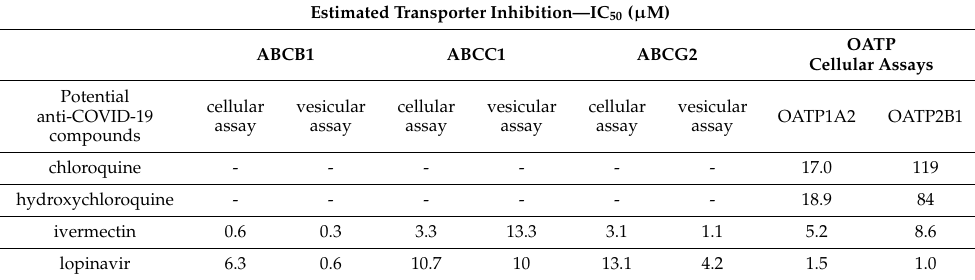
Figure 5. ( A , B ) Inhibition of OATP1A2-mediated sulforhodamine101 (SR101) uptake by potential antiviral compounds. Uptake of 0.5 µ M SR101 was measured in A431-OATP1A2 cells seeded on 96-well plates for 10 min in the presence of increasing concentrations of ivermectin (IVE), chloroquine (CQ), hydroxychloroquine (HCQ), favipiravir(FAV), lopinavir (LOP), ritonavir (RIT), remdesivir (REM), and SEBCD-remdesivir. ( C , D ) Inhibition of OATP2B1-mediated pyranine uptake by different antiviral compounds. Uptake of 20 µ M pyranine was measured in A431-OATP2B1 cells for 15 min in increasing concentrations of the tested compounds. In all cases, averages were obtained based on at least three biological replicates. +/- SD values are shown. Table 2. Summary of the transporter inhibition properties of the drugs examined. Approximate IC 50 ( µ M) values were determined by nonlinear regression analysis of the data shown in the results section, using GraphPad prism software (version 5.01, GraphPad, La Jolla, CA, USA).